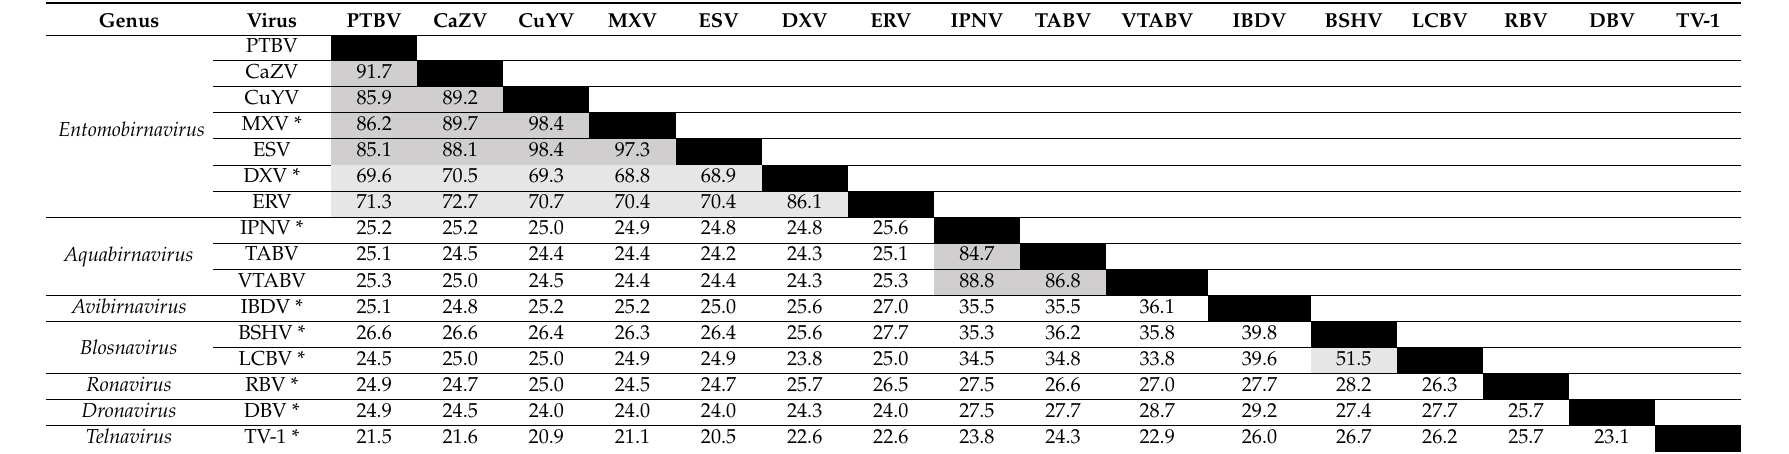
Table 2. Percentage amino acid sequence identities (p-distance) of a ClustalW alignment of birnavirus VP2-VP4-VP3 polyproteins.